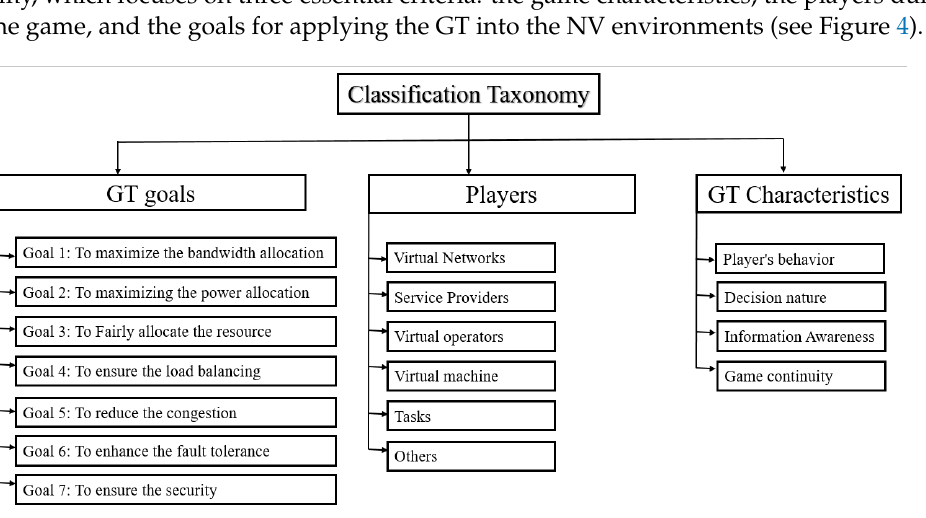
Figure 4. Classification taxonomy for the GT solution in the NV